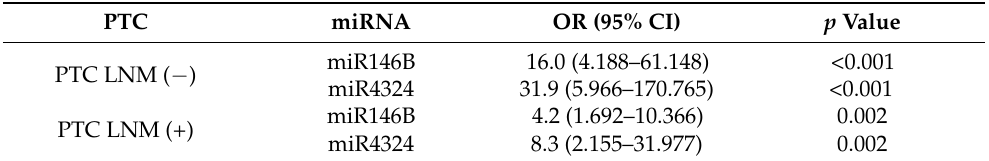
Table 7. Multivariable logistic regression analysis predicting histological category of PTC without LNM or PTC with LNM. The control category—BTN